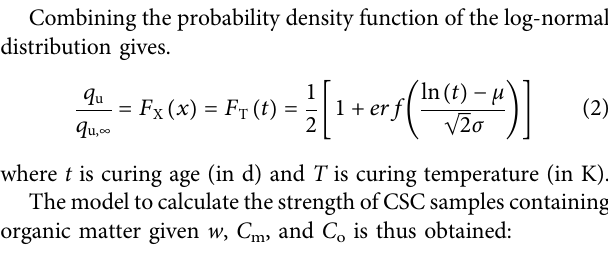
Frontiers in Materials |